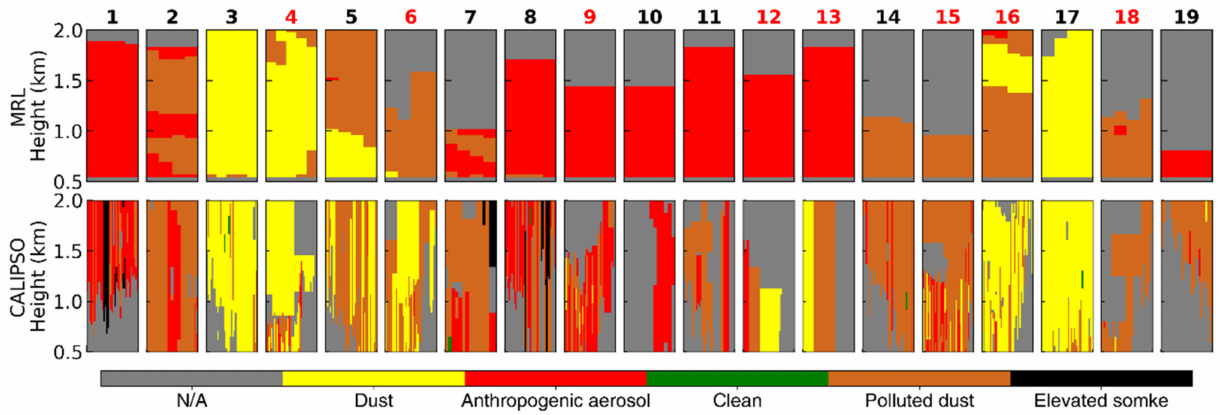
Figure 7. Aerosol subtype mask comparison between MRL and CALIPSO. The first line is the time–height plots of the classification results determined by MRL, and a temporal difference of less than 1 h between MRL and CALIPSO were selected. The second line is the latitude–height plots of the CALIPSO classification results, and the CALIPSO overpasses that occurred at a distance of less than 90 km were selected. The case number is displayed at the top of each subgraph, the black represents nighttime results, and the red indicates the daytime results, the details of each case can be found in Table 1. Color-coded aerosol type of polluted continental/smoke of CALIPSO is shown as anthropogenic aerosol